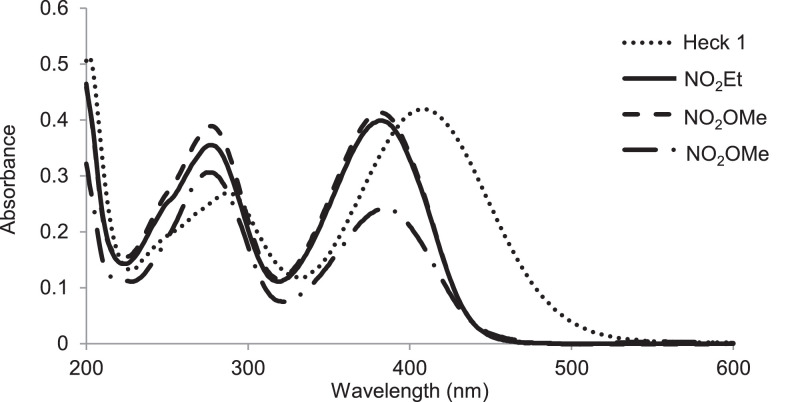
UV-Visible spectra of Heck 1, NO2Et, NO2Me and NO2OMe in acetonitrile, respectively.